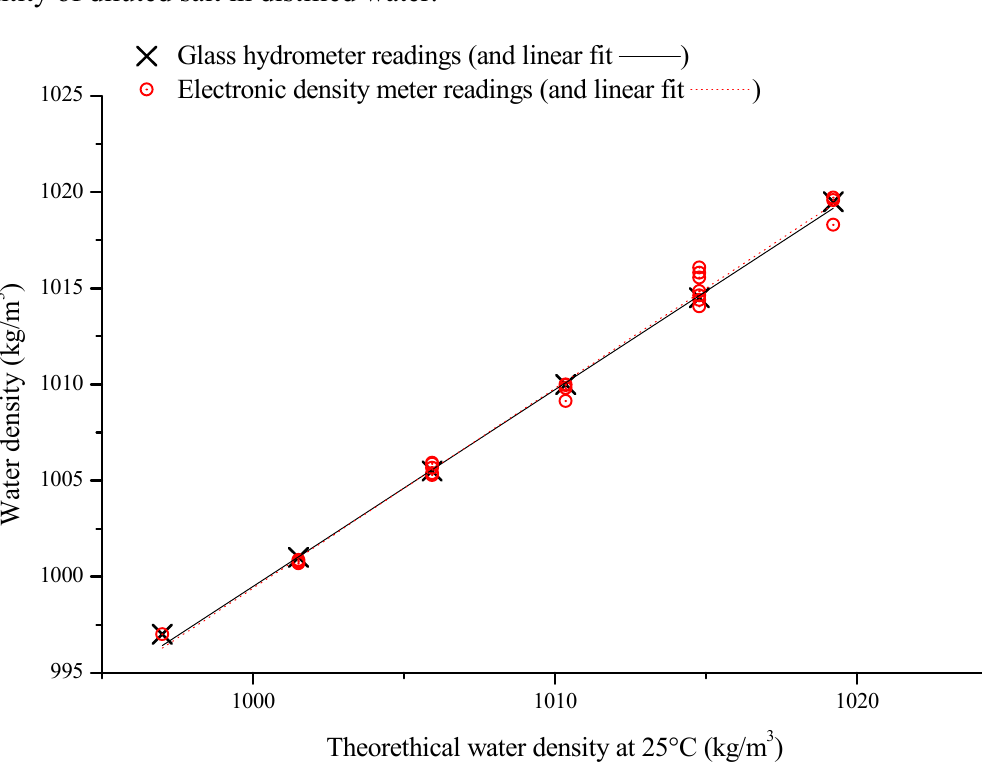
Figure 6. Water density values calculated by the wireless density meter node and by the reference glass hydrometer, as a function of the theoretical density value determined by the quantity of diluted salt in distilled